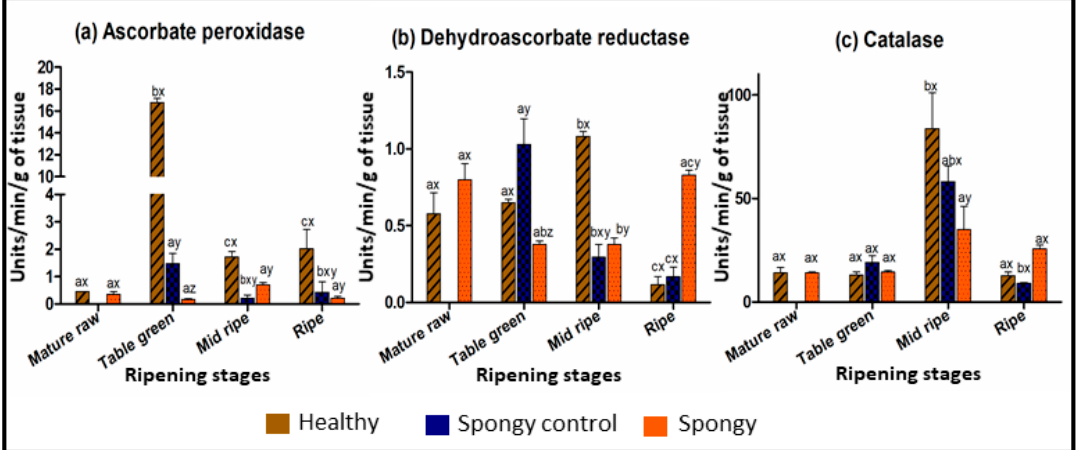
Figure 3. Enzyme assay. Average enzyme activity of ( a ) Ascorbate peroxidase ( b ) Dehydroascorbate reductase and ( c ) Catalase in units / min / g of healthy, spongy control and spongy tissue mesocarp of Alphonso mango fruit at various ripening stages. Vertical bar represents standard error calculated from six biological replicates. Di ff erence between the stages of each tissue set was significant ( p ≤ 0.05) if lower case letters (a, b, c) are di ff erent. Di ff erence between tissue sets at each ripening stage was significant ( p ≤ 0.05) if lower case letters (x, y, z) are different.